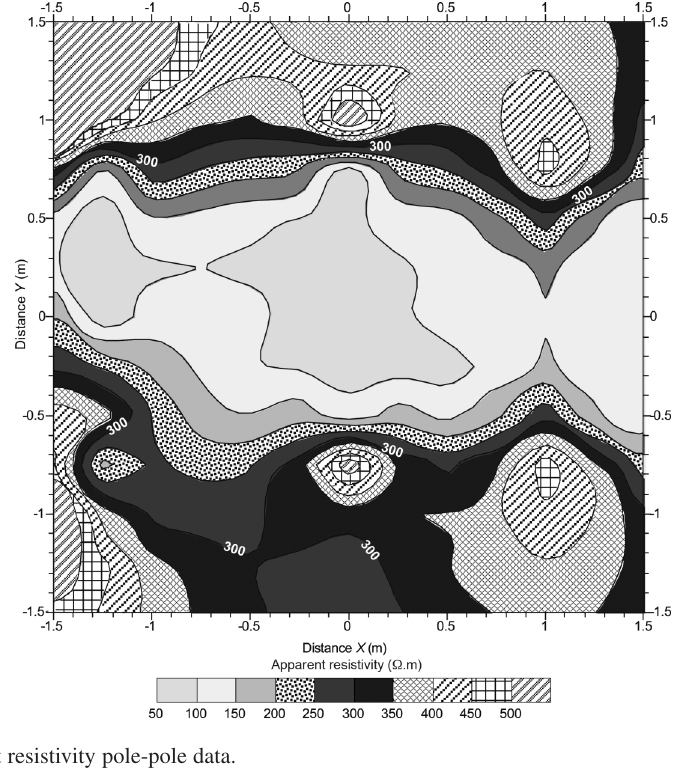
Fig. 4. Apparent resistivity pole-pole data.